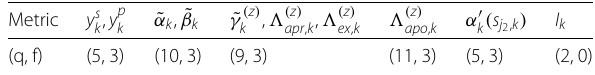
Table 2 Quantization schemes adopted in the simulation Metric